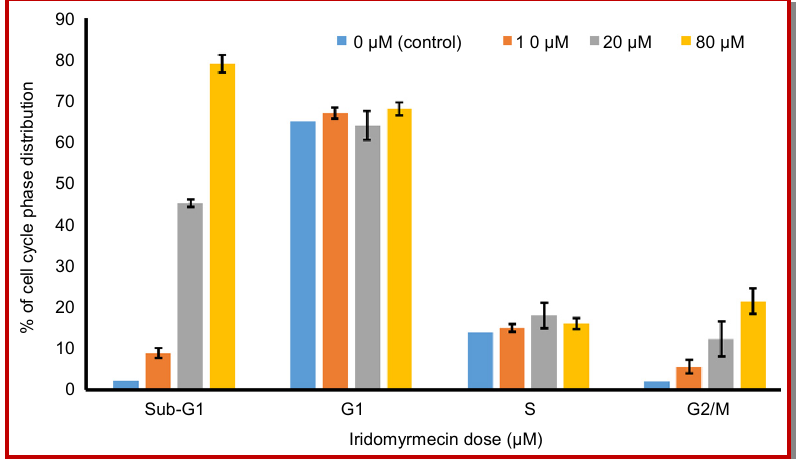
Figure 3: Iridomyrmecin induced significant sub-G1 and mild G2/M cell cycle arrest in human cervical cancer cells (HeLa). The cells were treated with 0, 10, 20 and 80 µM dose of iridomyrmecin for 48 hours and then analyzed by flow cytometry. There was a significant increase in the sub-G1 and G2/M phase cells as the dose of iridomyrmecin was increased